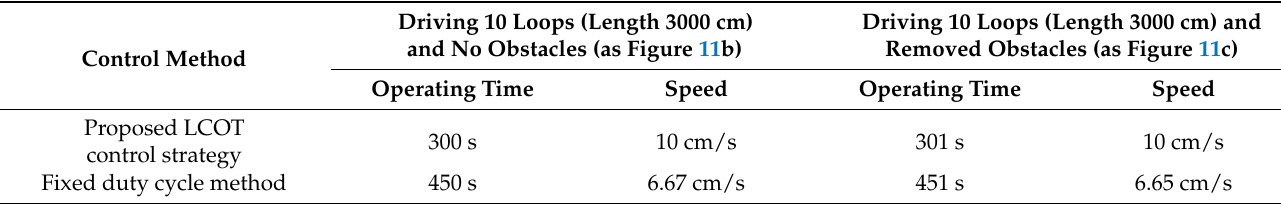
Table 4. Performance comparison of the two